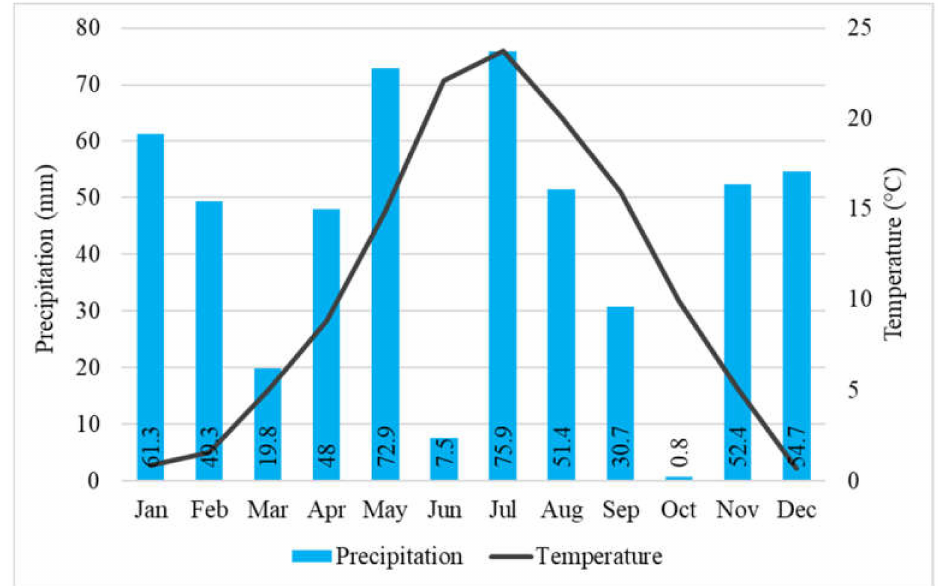
Figure 1. Monthly sums of precipitation and averages of temperature (Napkor, 2021). Numbers in the bars: sum precipitation of the